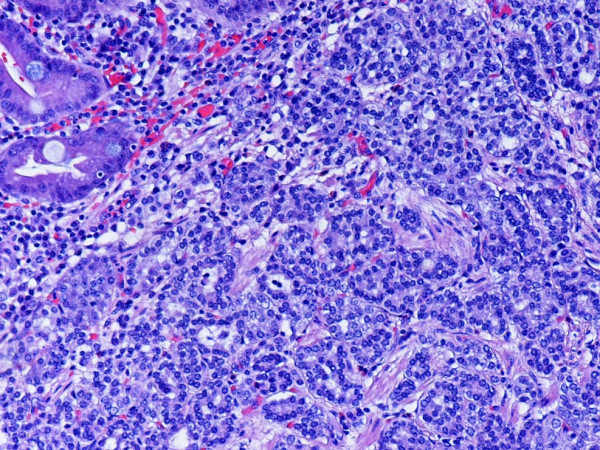
Representative section of the tumor showing the neuroendocrine carcinoma component. Intestinal metaplasia is noted in the upper left of the photo. H and E. Original magnification, × 200.